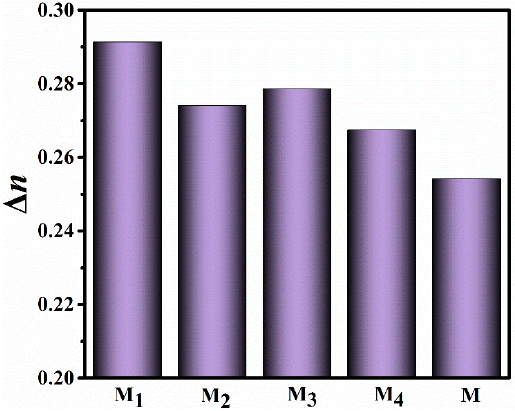
Figure 4. The frontier orbitals and energy levels of these benzoxazole LC compounds by DFT calculations.